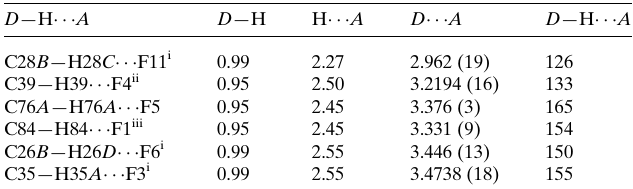
Table 1 Hydrogen-bond geometry (A˚ , (cid:4) ) for ( 1 ).